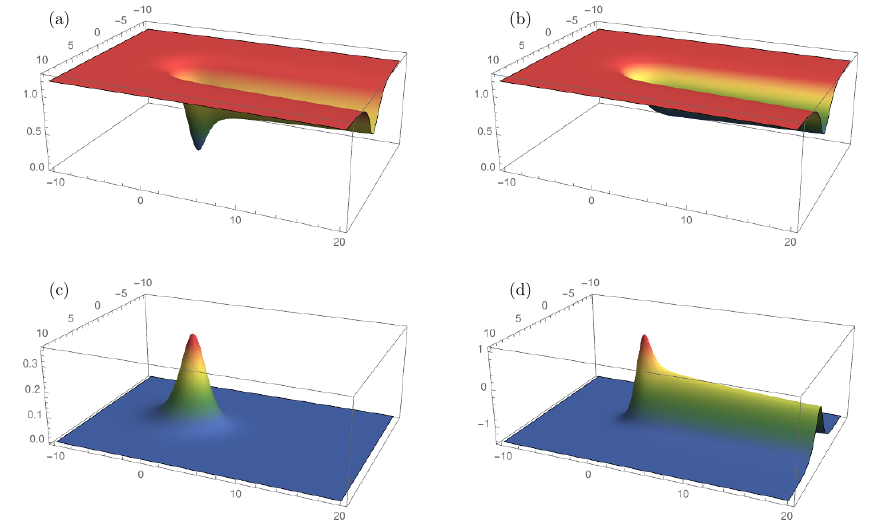
Figure 13 . A snap shot of the (1 ; 0)-string with a domain wall for (cid:24) = (cid:25) to the string. The panels (a) and (b) show the absolute square of the upper-left (winding) and the lower-right (unwinding) components, respectively. (c) shows the Z -(cid:13)ux and (d) shows the full energy density.